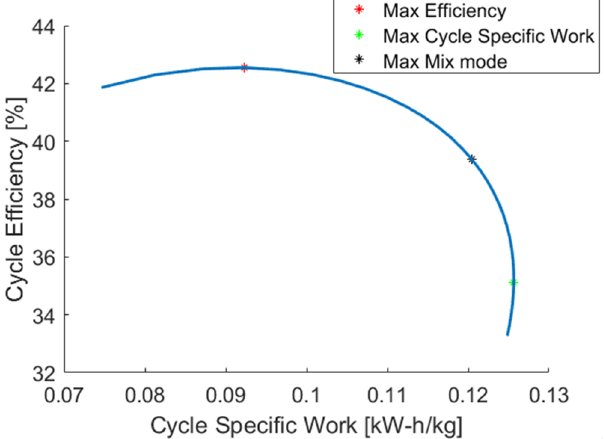
Figure 16. Cycle Efficiency along the cycle Specific Work of open-air Brayton cycle.